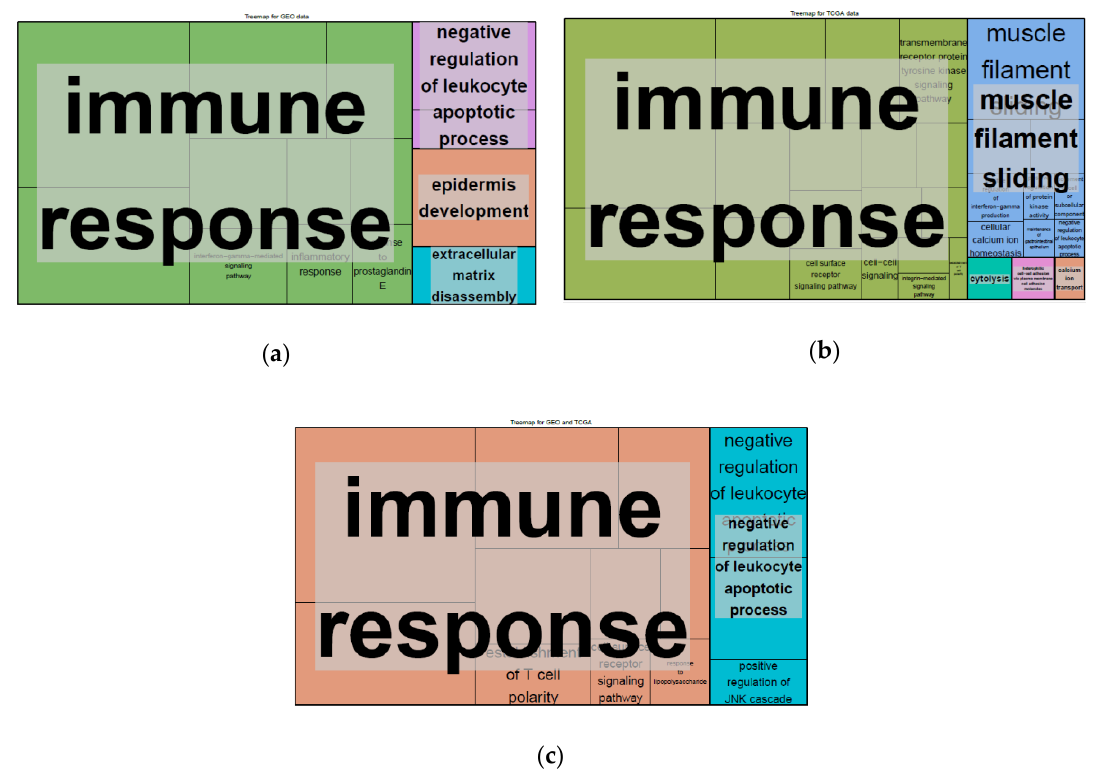
Figure 4. REVIGO tree maps of gene ontology terms for enriched biological processes in di ff erentially expressed genes (DEGs) associated with CD200R1 expression in the GEO (GSE65858) ( a ) and TCGA HNSCC ( b ) data. ( c ) Common DEGs associated with CD200R1 expression in the GEO (GSE65858) and TCGA HNSCC data. Box color indicates the functional category and box size is proportional to its corrected p